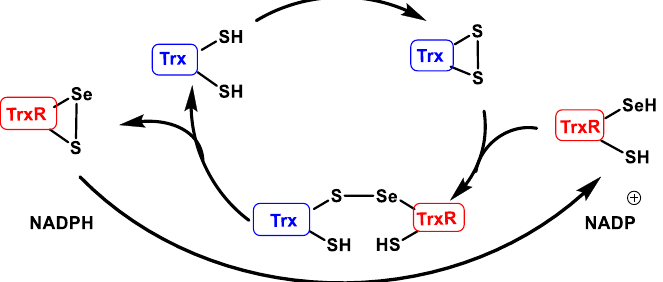
Figure 19. Thioredoxin reductase catalytic cycle (TrxR).